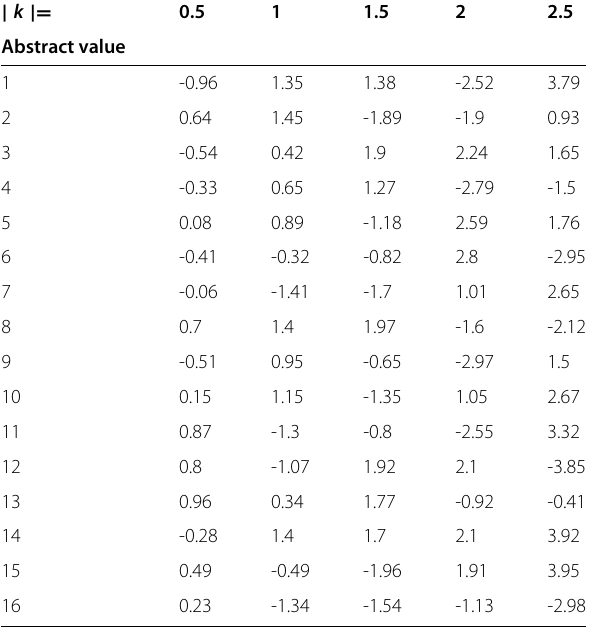
Table 2 κ values generated for five non-Gaussian distributions used to synthesize more general